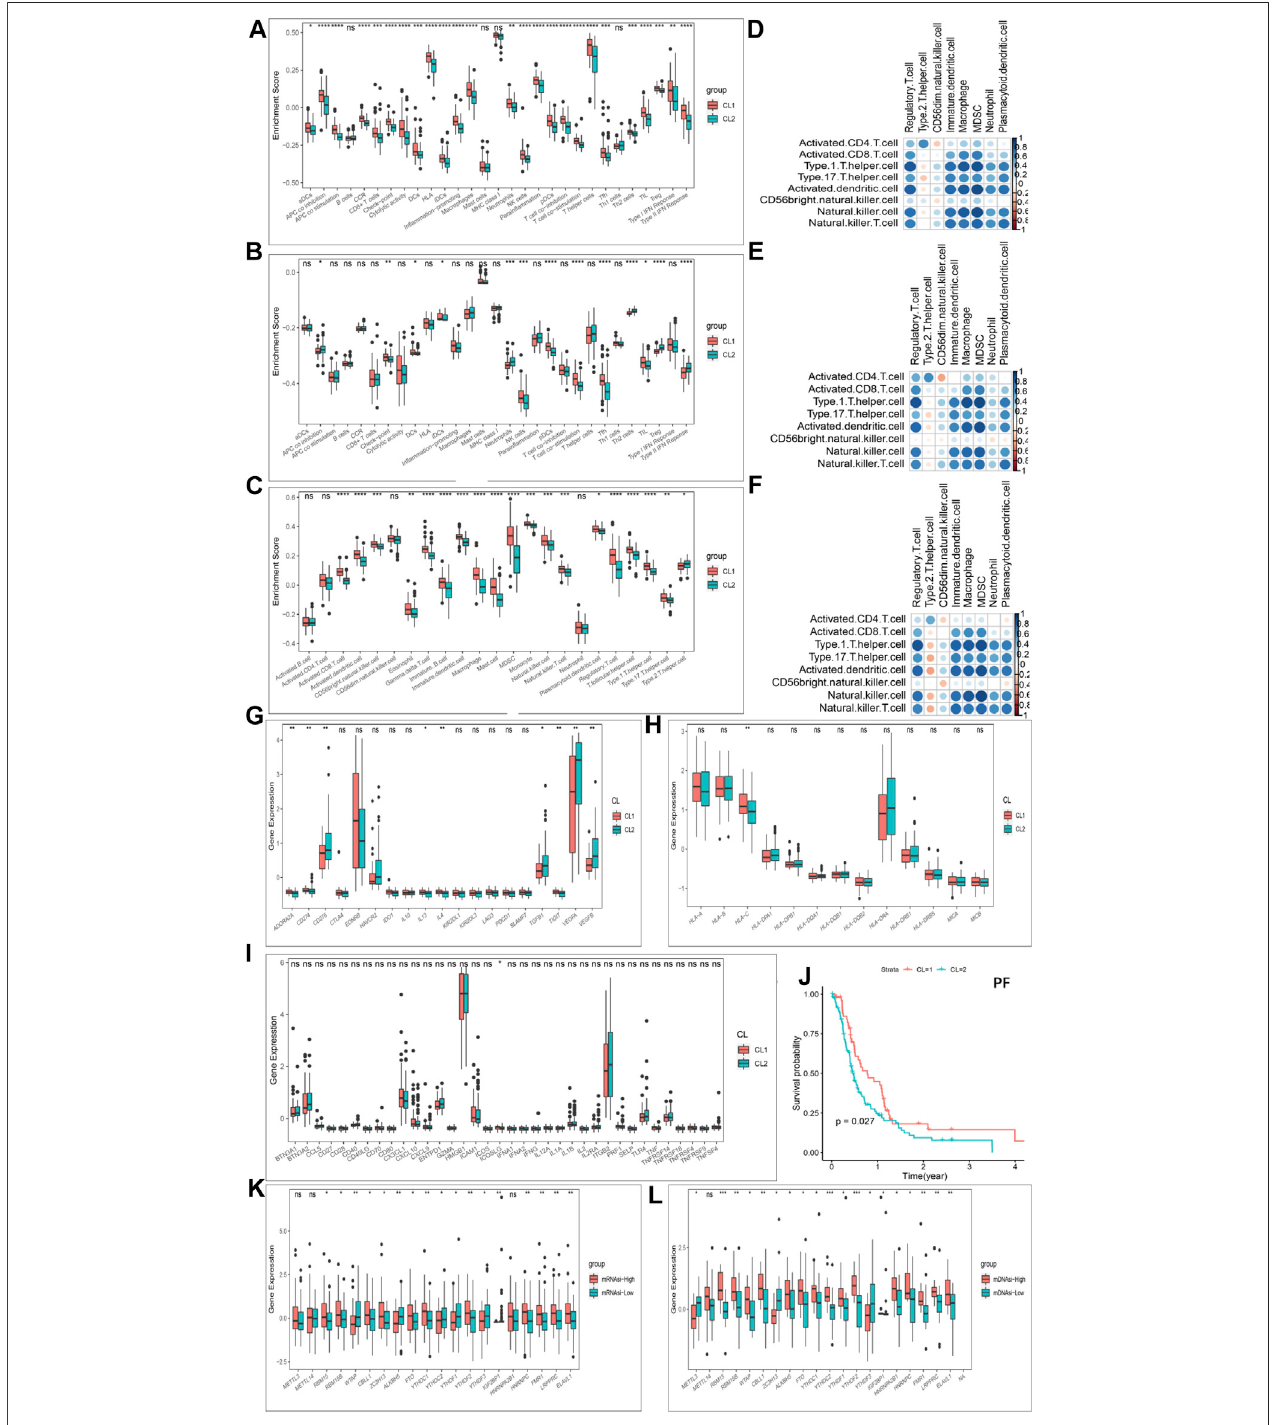
FIGURE4| Patternsofm6Amethylationmodi fi cationandbiologicalcharacteristicsofeach pattern. (A) Theenrichmentdifferencesofimmunesignaturesbetween CL1 and CL2 subgroupsin the TCGA-GBM cohort. (B) Theenrichment differences ofimmunesignatures between CL1 and CL2 subgroups in the CGGA-GBM cohort. (C) TheenrichmentfractiondifferencesofimmunecellsbetweenCL1andCL2subgroupsintheTCGA-GBM cohort. (D – F) Correlationofsamplesbetweenin fi ltrationof cell types executing pro-tumor, immune-suppressive functions (pDC, Neutrophil, CD56dimNK, TAM, imDC, Th2, MDSC, and Treg) and cell types executing anti- tumor immunity (NKT, TemCD4, TemCD8, ActCD4, ActCD8, Th1, Th17, ActDC, TcmCD4, TcmCD8, CD56briNK, and NK). (D) All samples in the TCGA-GBM cohort. (E) CL1 group samples in the TCGA-GBM cohort. (F) CL2 group samples in the TCGA-GBM cohort. (G) Differences in the expression of inhibitor genes in the CL1